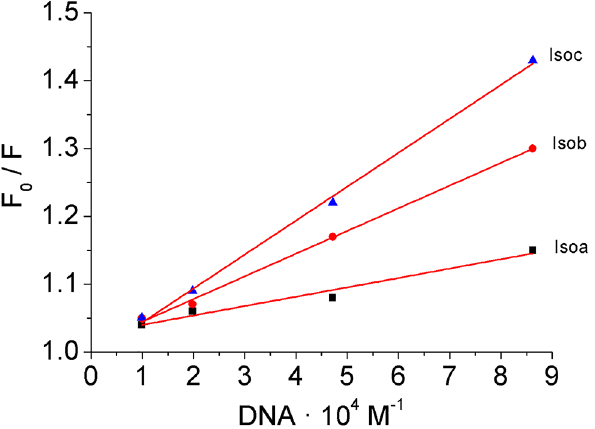
Fig 6. Stern-Volmer plots for the fluorescence quenching of Isoa-c by DNA. Plot of the ratio of the isophorone derivatives fluorescence intensity before and after incremental addition of DNA as a function of the quencher concentration for the determination of the Stern-Volmer quenching rate constant.